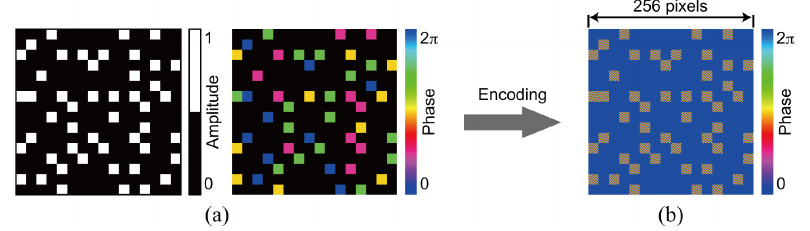
Figure 8. Data page 2. ( a ) complex amplitude distribution and ( b ) phase hologram.